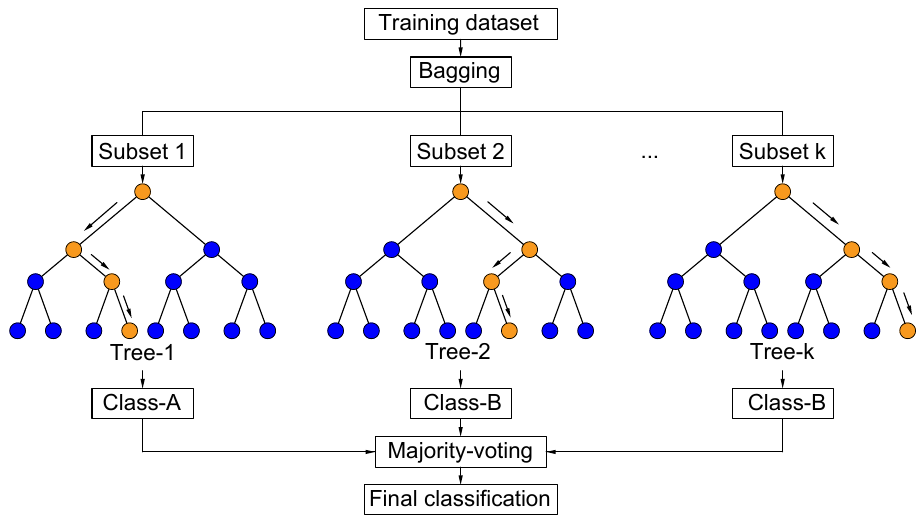
Figure 5. Flowchart of RF as a classifier